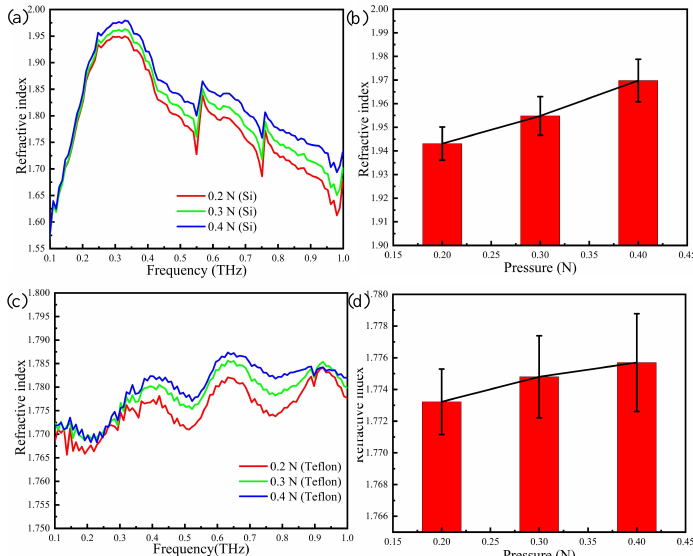
Figure 8. The refractive index of the thumb skin with different prisms: ( a ) the refractive index spectra: silicon; ( b ) error tree diagram of the reflectance at 0.3 THz: silicon; ( c ) the refractive index spectra: Teflon; ( d ) error tree diagram of the reflectance at 0.3 THz: